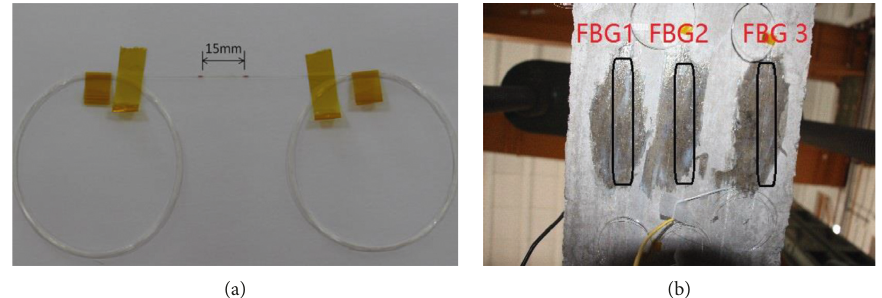
Figure 6: Fixing FBG sensors. (a) Bare FBG sensor. (b) Pasting of FBG sensors.